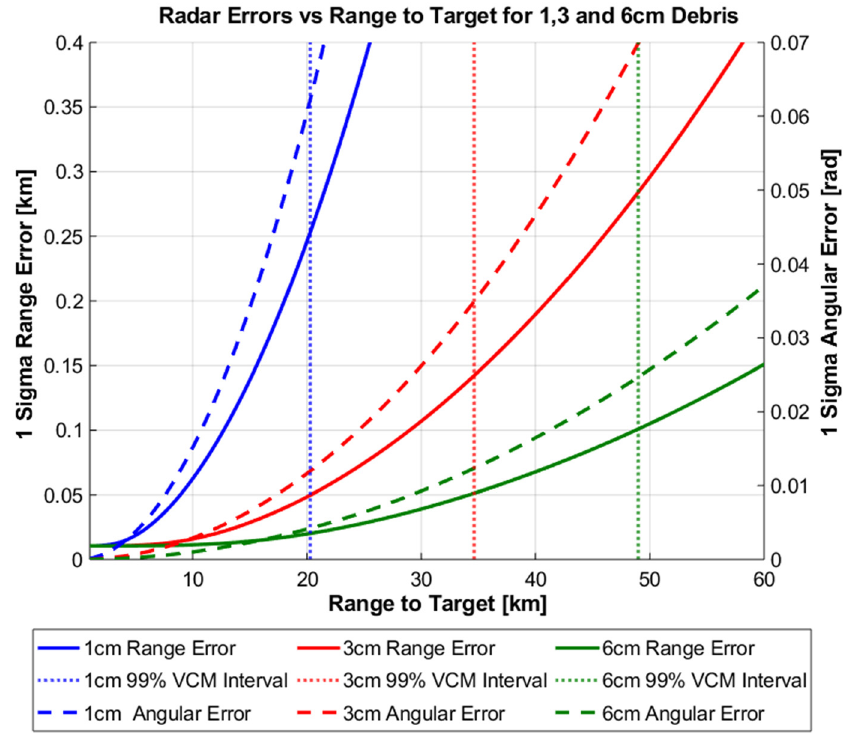
Figure 10. Ground Based Radar range and angular errors as a function of range to target.